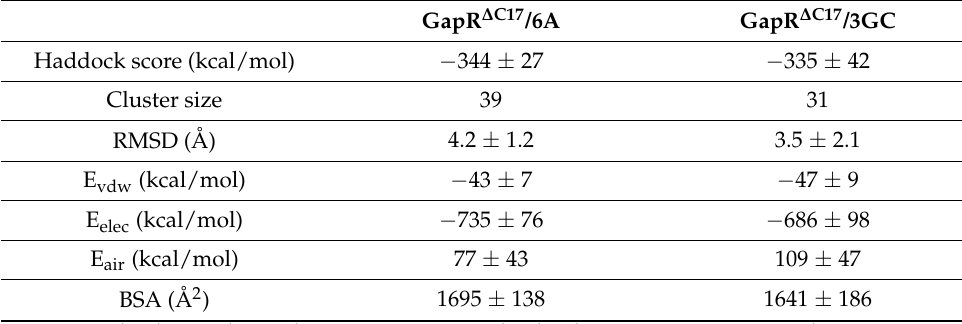
Figure 3. Haddock models of GapR Δ C17 in complex with 6A or 3CG DNA. ( A ) GapR Δ C17 /6A complex model with the lowest Haddock score in the top cluster. The sidechains of lysine/arginine residues interacting with DNA are shown as sticks, and those close to DNA phosphate groups are colored pink (monomer 1) or light blue (monomer 2). ( B ) GapR Δ C17 /3GC complex model with the lowest Haddock score in the top cluster. ( C ) Comparison of the structures of 6A and 3CG DNA. ( D ) For each complex model in the top Haddock clusters of GapR Δ C17 /6A and GapR Δ C17 /3GC, the number of arginine and lysine residues close to DNA phosphate groups (d NE/NH1/NH2-OP1/2 < 3.3 Å, d NZ-OP1/2 < 3.3 Å,) were calculated. The electrostatic energy of each complex model in the top clusters was presented below. Table 2. Statistics of the top Haddock cluster of GapR ∆ C17 with 6A or 3GC